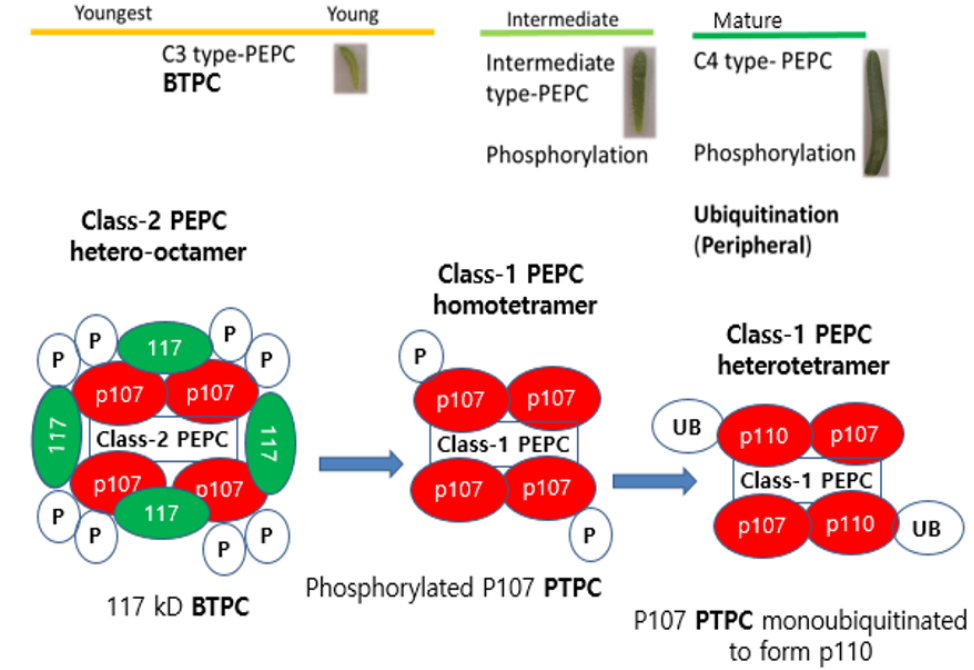
Figure 2. Potential working scheme for Bienertia sinuspersici phosphoenolpyruvate carboxylases (PEPCs). Class-2 hetero-octameric PEPCs, associated with bacterial-type PEPCs (BTPCs), are potentially expressed during the early stage of leaf development, while Class-1 homotetrameric PEPCs are expressed during the intermediate and mature stages of leaf development and include phosphorylated (P) p107 PTPC and monoubiquitinated (UB) p110 PTPC subunits. While the hetero-octameric Class-2 PEPC is highly expressed in young leaves of B.